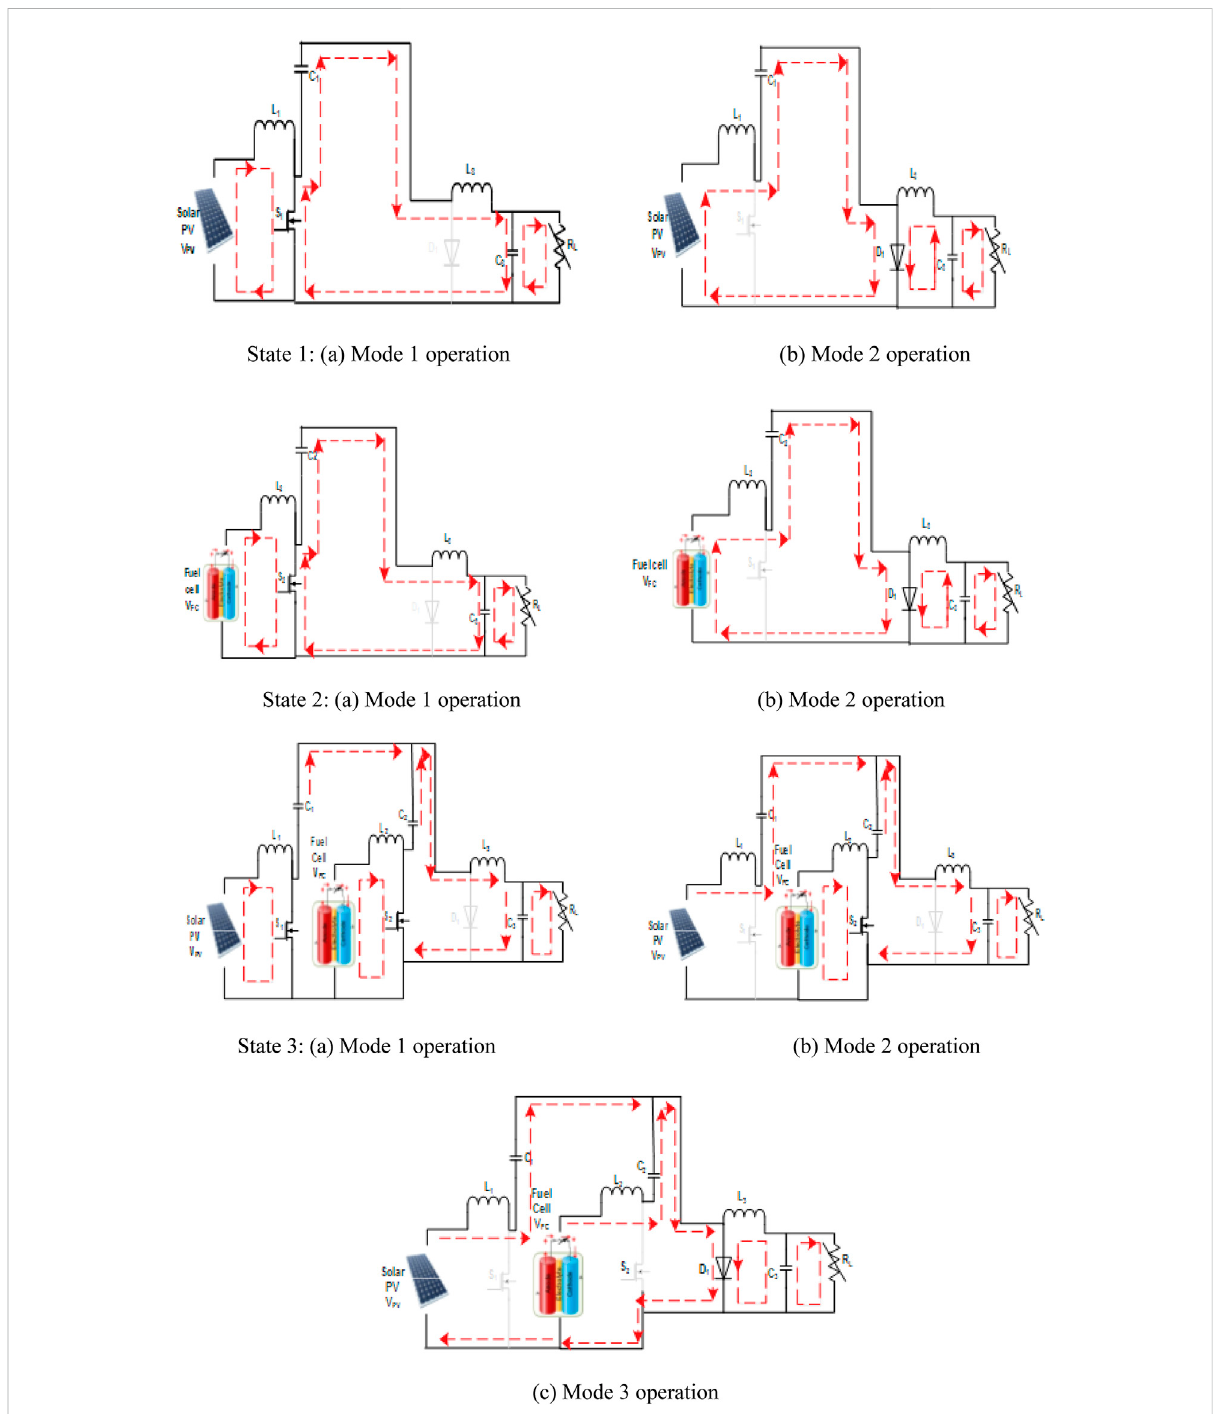
FIGURE 4 Mode of operation of the proposed DC-DC converter. State 1: (A) mode 1 operation (B) mode 2 operation. State 2: (A) mode 1 operation (B) mode 2 operation. State 3: (A) mode 1 operation (B) mode 2 operation (C) mode 3